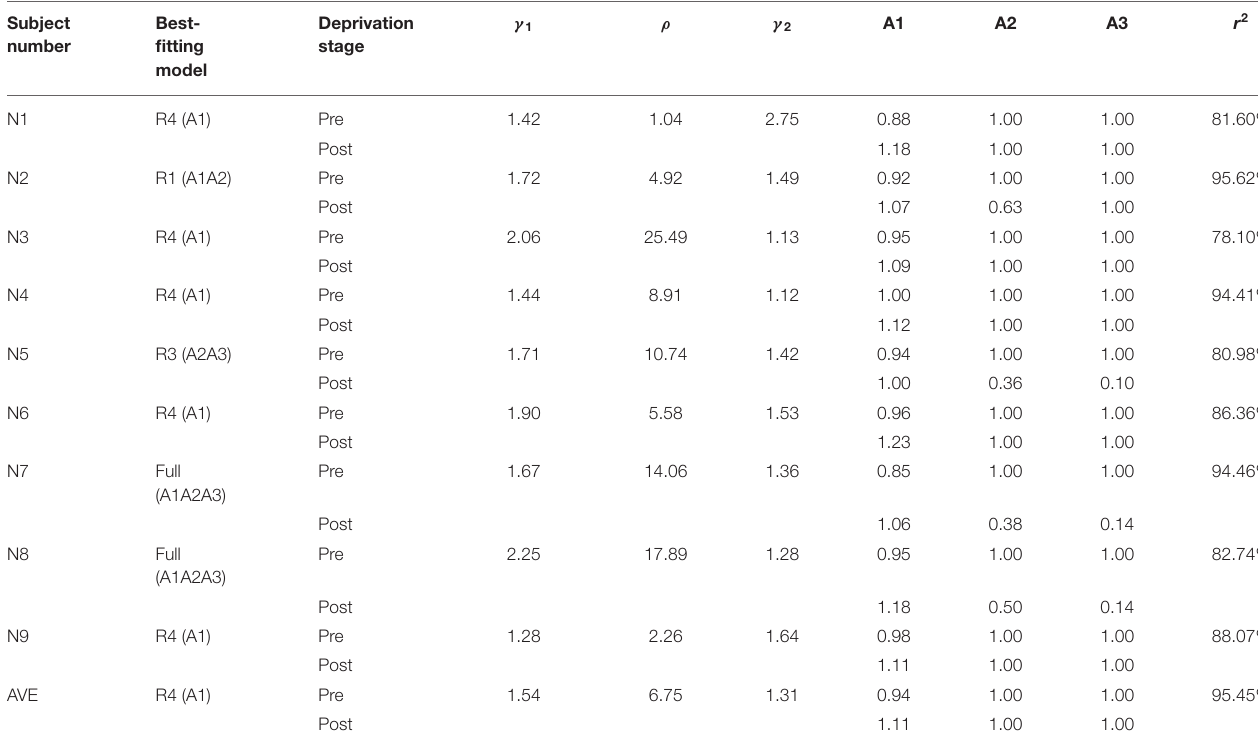
TABLE 2 | Parameters of the best-fitting